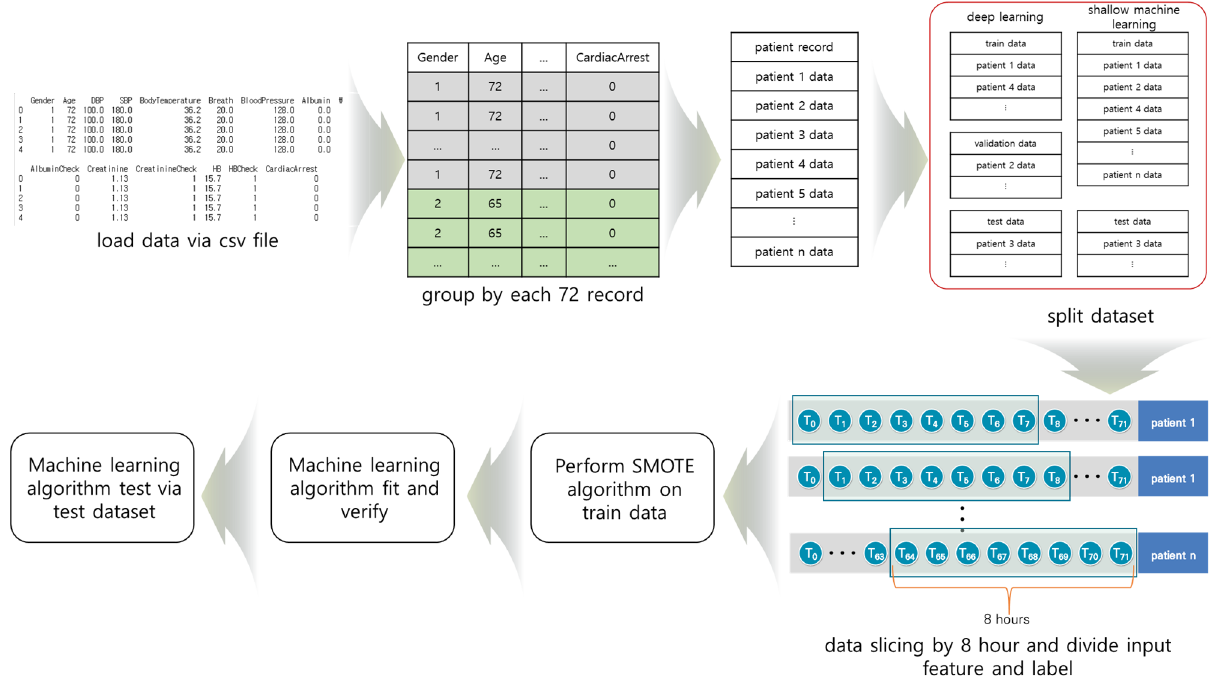
Figure 1. The process of cardiac arrest prediction: (1) data collection from the CSV file, (2) grouping of the data, (3) division of the data into training, verification, and test data, (4) data slicing, (5) Synthetic Minority Oversampling Technique (SMOTE) algorithm was performed on the training data, and (6) the machine learning algorithm.